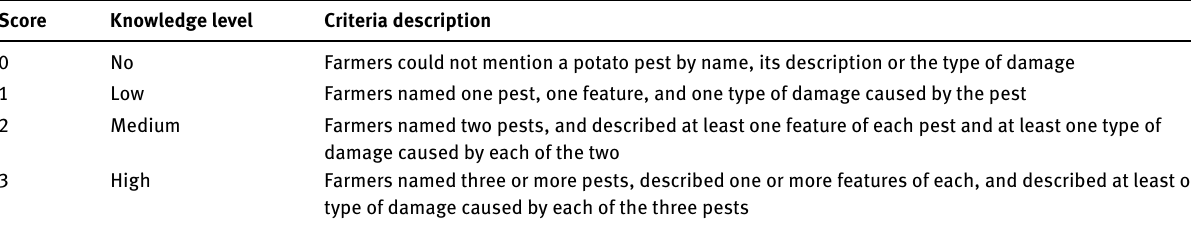
Table 1: Some criteria followed for scoring farmers’ knowledge of insect pests Score Knowledge